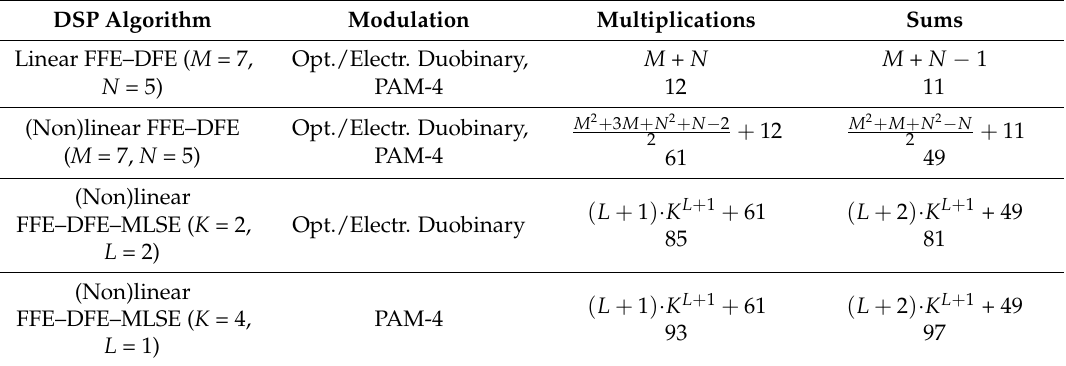
Table 1. Complexity (number of multiplications and sums per symbol) of various DSP algorithms. DSP Algorithm Modulation